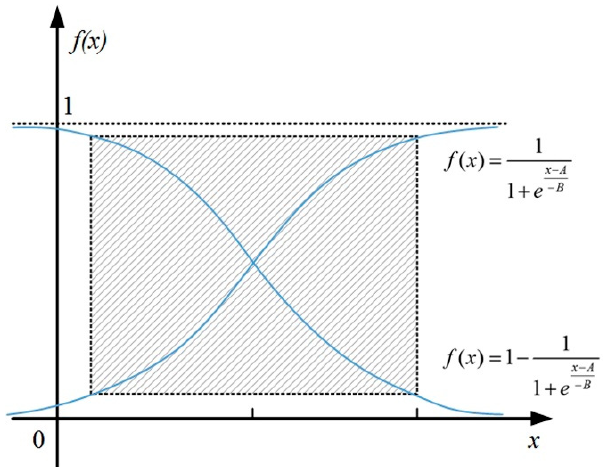
Figure 5. The traditional sigmoid function.